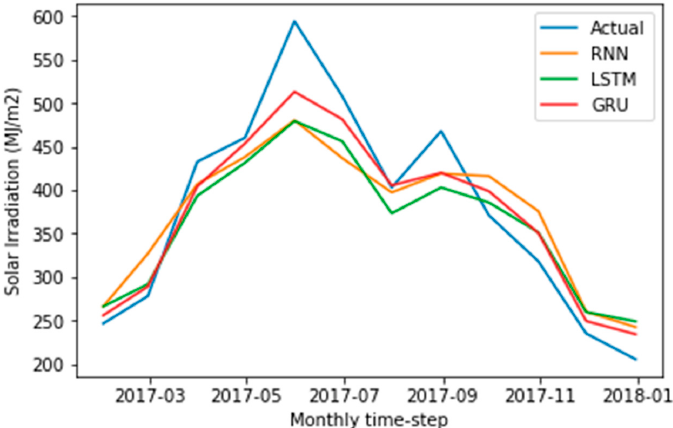
Figure 12. Comparison of RNN and its extensions in monthly time steps for Seoul Region. Energies 2020 , 13 , x FOR PEER REVIEW